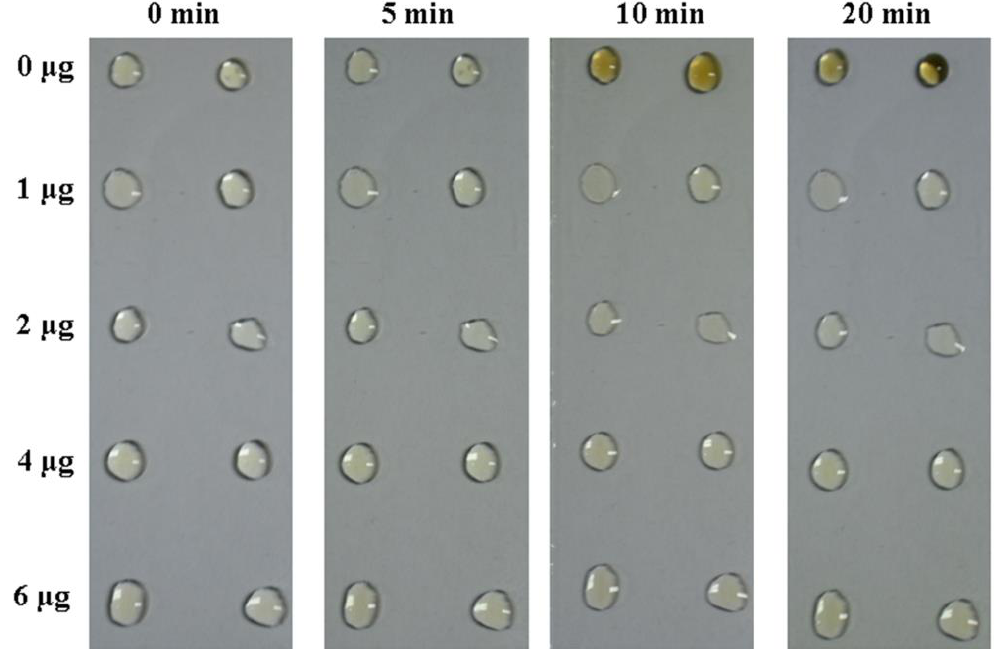
Figure 6. Bmserpin2 inhibits melanization in silkworm haemolymph. Cell-free haemolymph was mixed with different amounts of recombinant Bmserpin2. The control was prepared without Bmserpin2. The change in colour of haemolymph was observed and photographed.